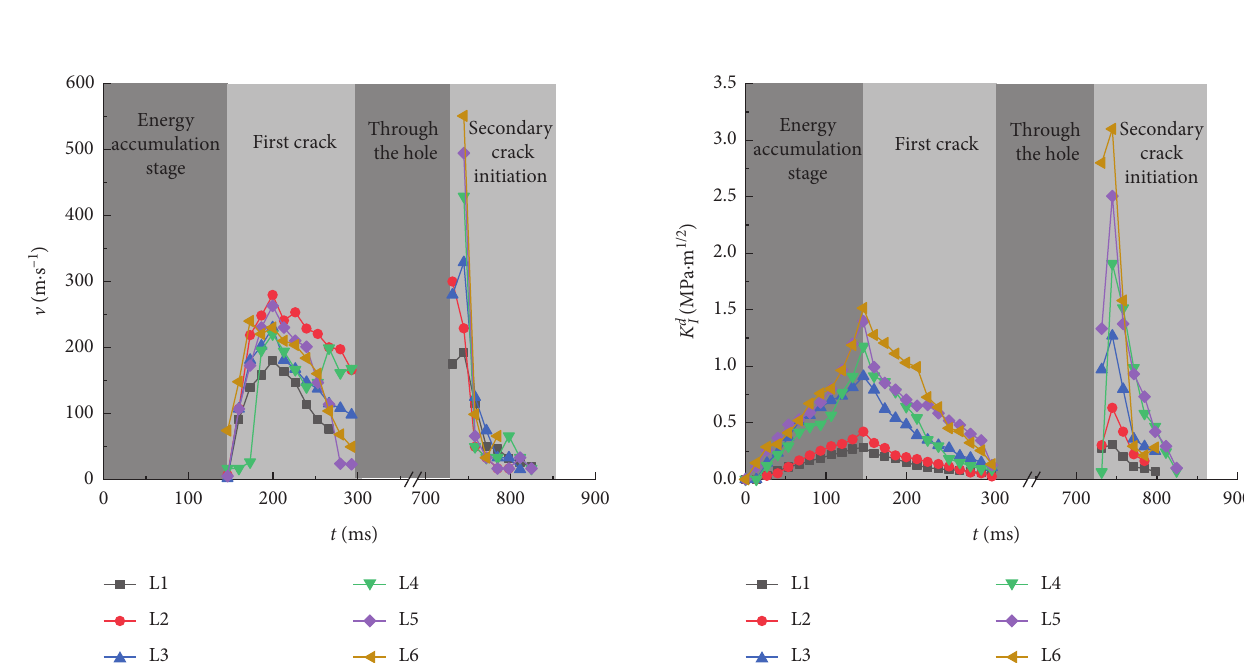
Figure 5: Moving crack trajectory diagrams through elliptical defects. (a) In from the left and out from the middle. (b) In from the left and out from the right. (c) In from the right and out from the middle. (d) In from the right and out from the left. (e) Into the middle and out from the left. (f) Into the middle and out from the middle. (g) Into the middle and out from the right.